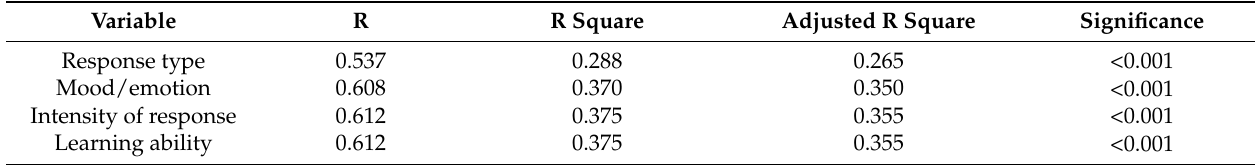
Table 4. Model summary of stepwise linear regression with transformed